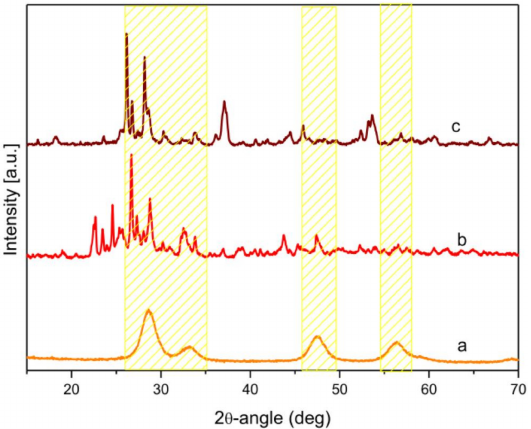
Figure 2. X-ray patterns of: GDC support (spectrum a)—NiMoCo/GDC sample after calcination (spectrum b), and after reduction (spectrum c). Features arising from the GDC support are yellow-highlighted.